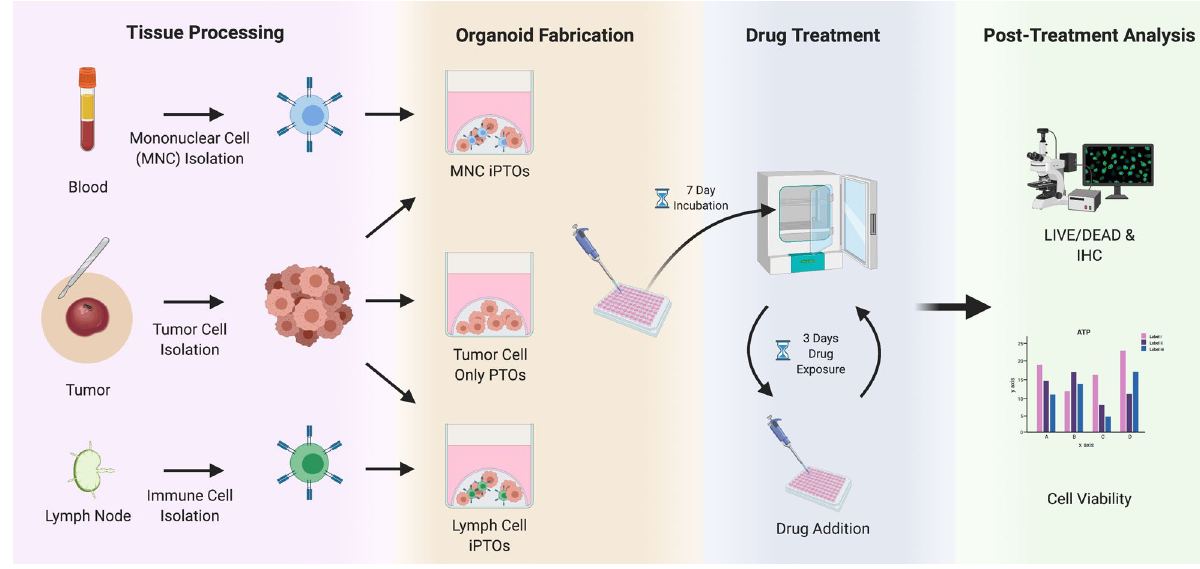
Figure 1. Flow chart of Merkel cell carcinoma organoid fabrication. Tumor cells were isolated from digested tumor tissue and fabricated into PTOs, while immune cells were isolated from patient blood or from lymph tissue and combined with tumor cells to create iPTOs. These organoids were cultured for 1 week, after which they were characterized and screened for therapeutic efficacy. Created with BioRender.com.